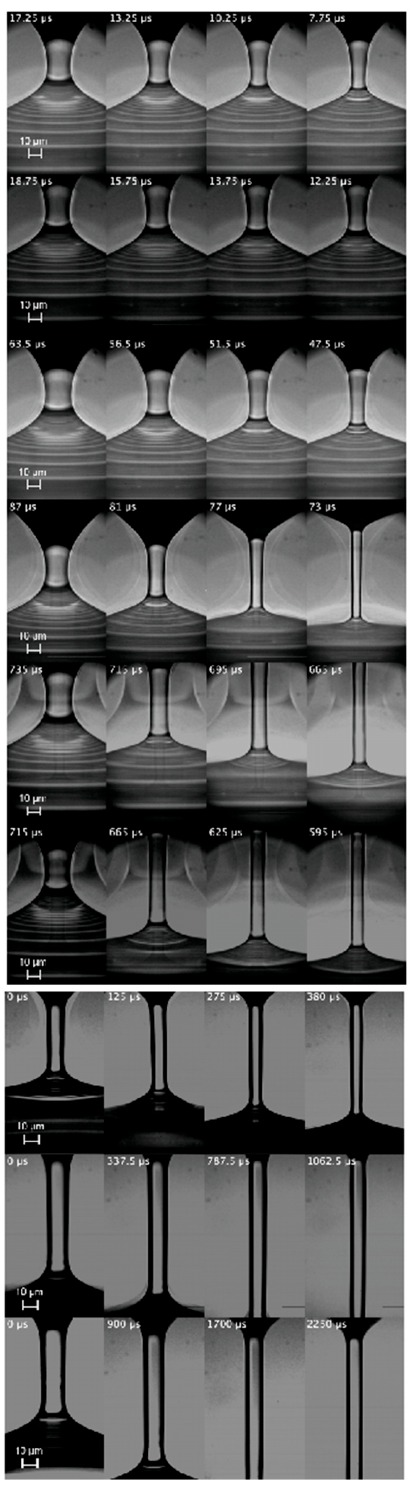
Figure 5 Figure 5. (From top to bottom) Images of the filament thinning over the elasto-capillary regime of PEO2M-0.0003, PEO2M-0.0005, PEO2M-0.001, PEO2M-0.002, PEO2M-0.004, PEO2M-0.007, PEO2M-0.01, PEO2M-0.03 and PEO2M-0.1. The labels indicate the time to the pinching. The white line separates the discarded realizations from those were the linear elasto-capillary regime was